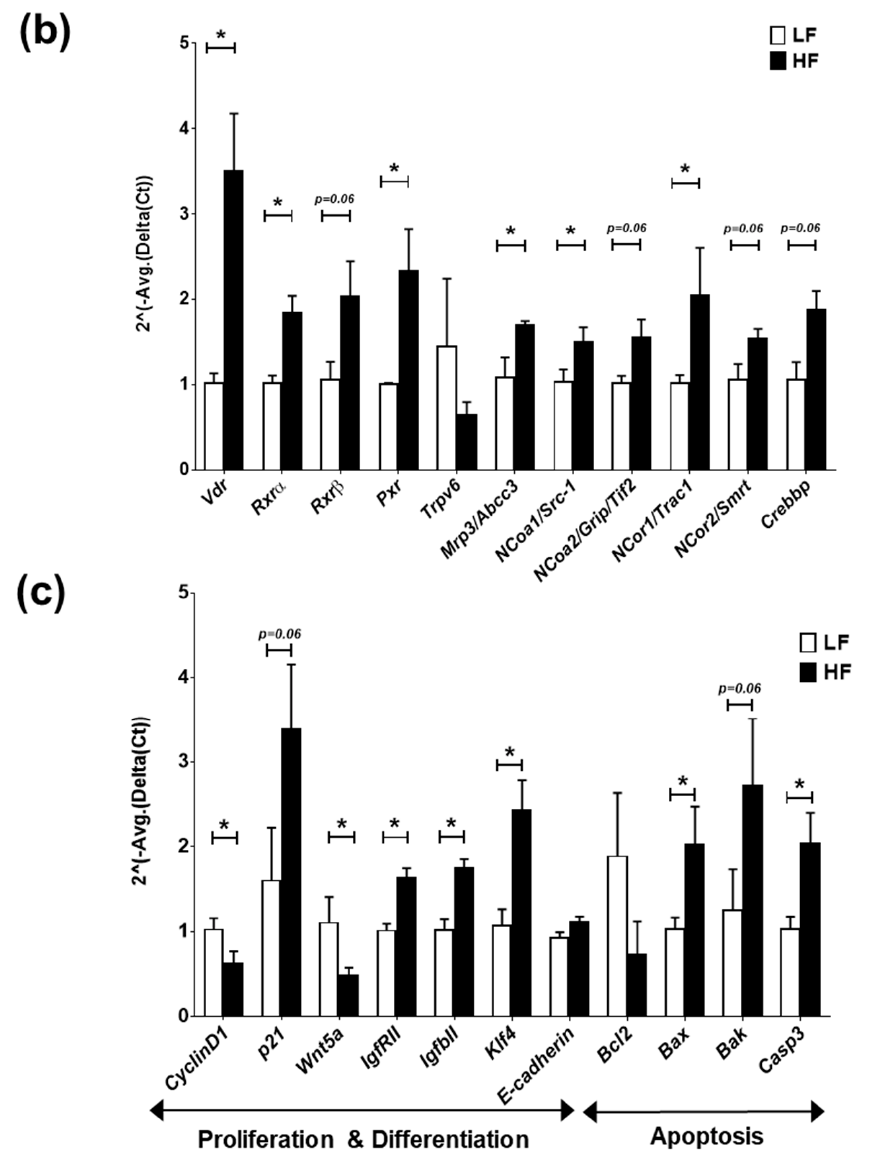
Figure 5. High-fat diet induces LCA which activates VitD-regulated genes in colonic tissue. ( a ) Faecal secondary bile acids UCDA, LCA, and DCA. Data are mean ± SEM. n = 4–5 mice per group. Significances were determined using ANOVA with post-hoc corrections. # p < 0.05 and ### p < 0.001 LF-Colitis or LF-CAC vs. LF-Ctr; % p < 0.05, %% p < 0.01, and %%% p < 0.001 HF-Colitis or HF-CAC vs. HF-Ctr; $ p < 0.05, $$ p < 0.01, and $$$ p < 0.001 HF-Colitis vs. LF-Colitis; &&& p < 0.001 HF-Ctr vs. LF-Ctr. ( b ) Expression of genes in the VitD pathway and ( c ) of VitD-regulated genes in tumour-free colonic tissue from mice with LF-CAC and HF-CAC. Expression was determined as n-fold induction compared with the β -actin housekeeping gene and normalised to the LF group. Bars represent the mean ± SEM, n = 3–4/group. * p < 0.05 HF-CAC vs. LF-CAC as determined by two-tail unpaired Student’s t -test. Ctr—control; CAC—colitis-associated